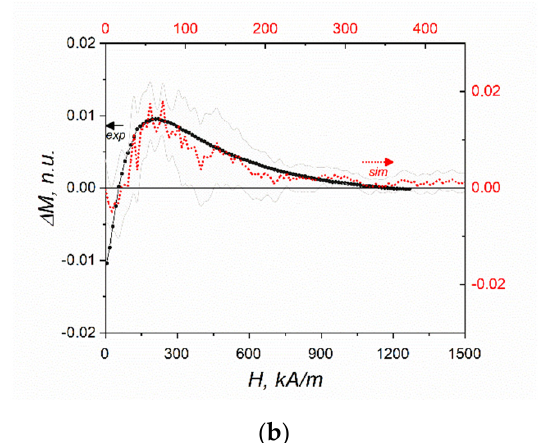
Figure 4. ( a ) Snapshot of the system of ferromagnetic and ferroelectric particles in the simulation box demonstrating an MD model of a multiferroic material: blue spheres are FM particles, orange ones are FE particles, white arrows show their magnetic/electric polarizations, green spheres are polymeric beads, green lines denote elastic links; the snapshot region is 10 × 50 × 50 μ m along Ox, Oy, and Oz axes, respectively. ( b ) Magnetization increment ∆ M ( H ) = M ( H ) E − M ( H ) 0 , where M ( H ) 0 and M ( H ) E are magnetizations in normalized units measured without electric bias and under an electric bias of 5 MV/m; experimental data (black) and simulation data (red) with error bars (grey) [30]. H denotes the magnetic field strength.